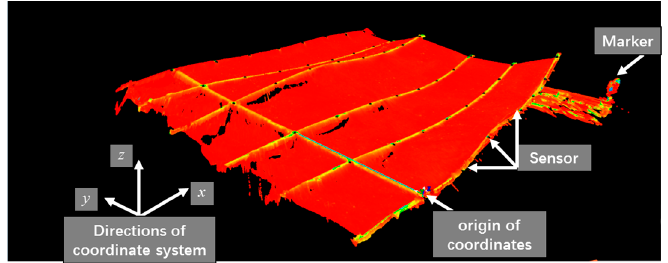
Figure 18. ( a ) Landslide phenomenon simulation test; ( b ) Collapse phenomenon simulation test.